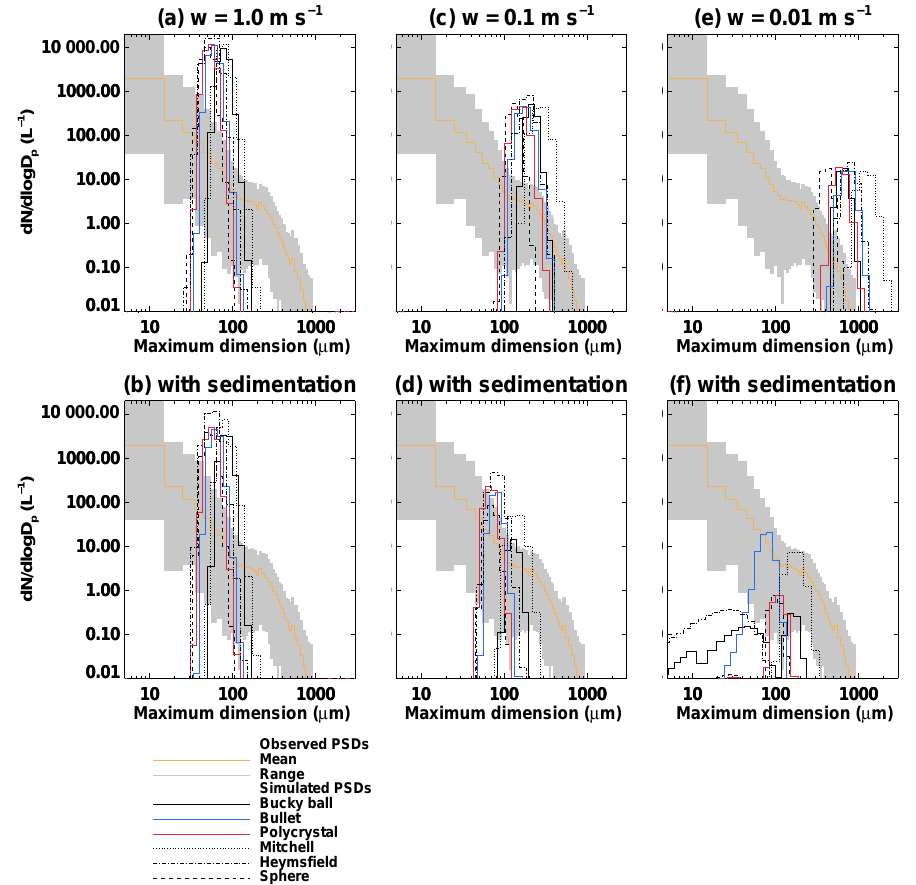
Figure 17. Ice particle size distributions (PSDs) simulated at − 55 ◦ C with different ice properties (see legend) and different updraft speeds without sedimentation (top row) and with sedimentation (bottom row). For context are shown also the mean and range of all PSDs observed over the 1–2 April flights using an in-cloud ice water content threshold of 0.001gm − 3 following Jackson et al.